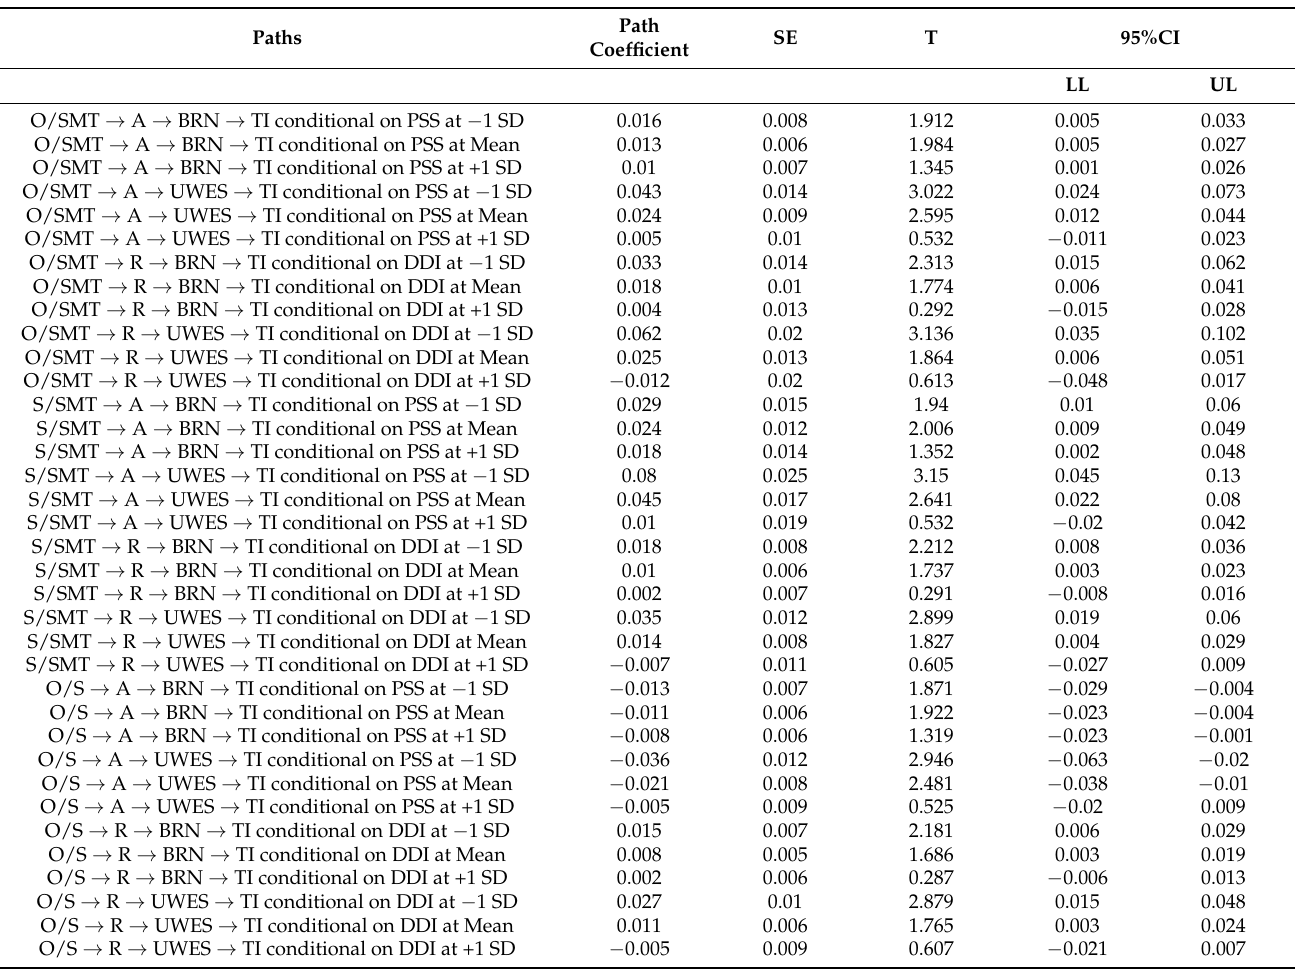
Table 4. Conditional Moderation